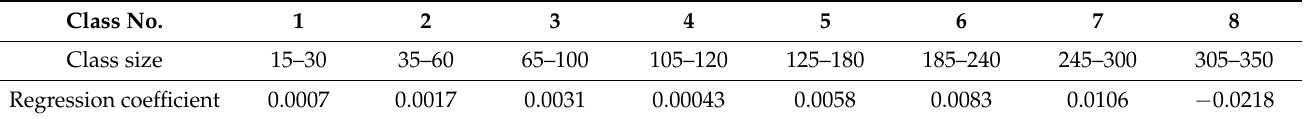
Table 5. Regression coefficient table for eight classes.